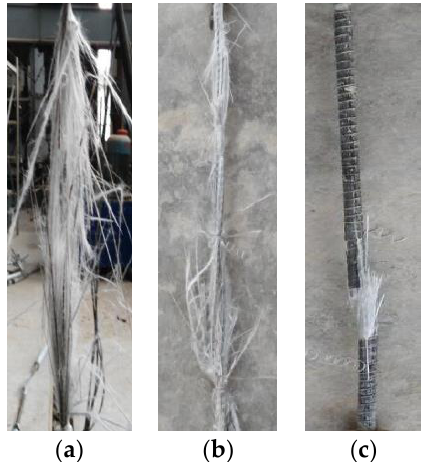
Figure 2. Failure modes of GFRP bars under cyclic load: ( a ) form of blasting damage; ( b ) form of splitting damage; and ( c ) form of fracture failure.